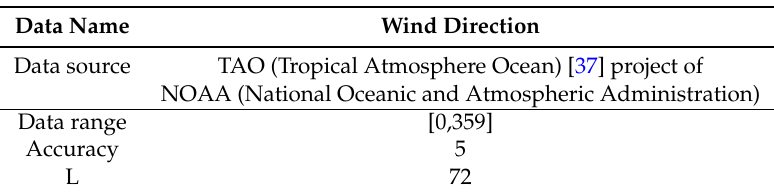
Table 6. Data description of the real